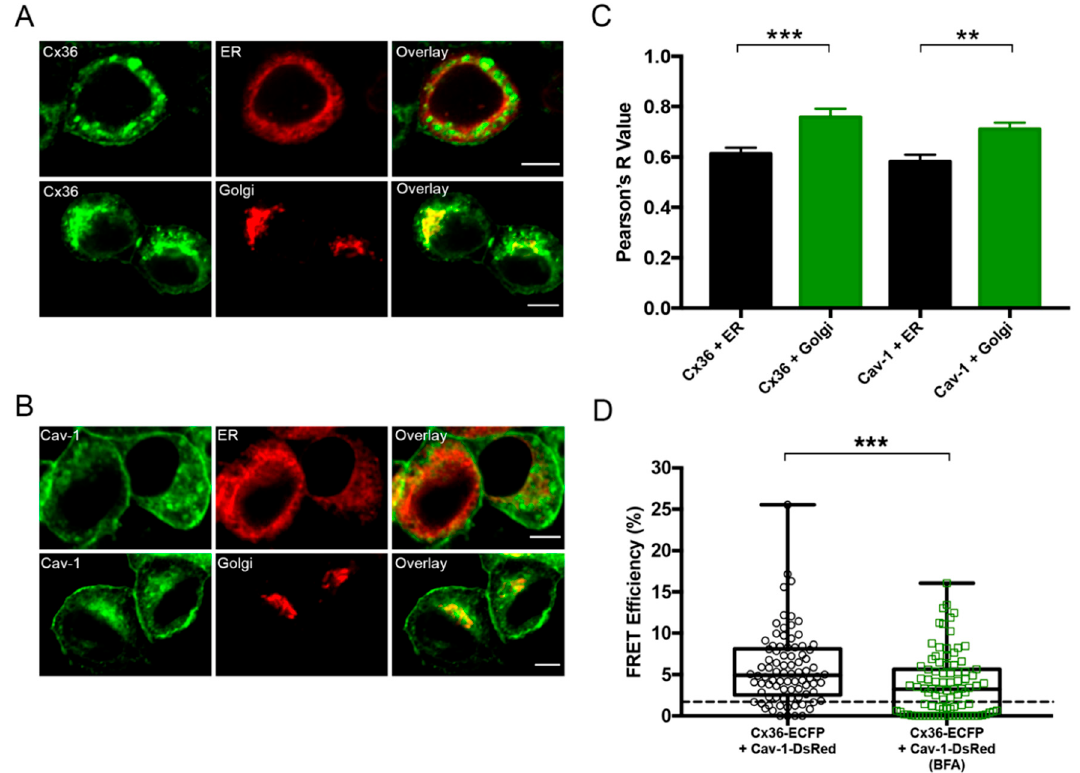
Figure 3. Co-localization with cellular markers and FRET analysis of Cx36 and Cav-1 post Brefeldin A (BFA) treatment. ( A, B ) Co-localization of Cx36-HIS and Cav-1-HA with DsRed-tagged calreticulin (ER marker), and DsRed-tagged galactosyltransferases (Golgi apparatus marker). HIS-tagged Cx36 was detected using an anti-HIS antibody and HA-tagged Cav-1 was detected using an anti-HA antibody. Alexa Fluor 568 was used as a secondary antibody. Scale bar: 5 µm ( C ). Co-localization quantification of the Cx36 and Cav-1 with the organelle markers. Error bars show standard error of the mean. Sample sizes were the following: Cx36 and ER: n = 30; Cx36 and Golgi: n = 20; Cav-1 and ER: n = 21; Cav-1 and Golgi: n = 19. ( D ) FRET efficiencies of Neuro 2a cells transfected with Cx36 and Cav-1 with and without BFA treatment. The threshold of 1.7% (equals to 10nm) is represented by the dotted line. Error bars show the minimum and maximum values. Sample sizes were the following: Cx36-ECFP + Cav-1-DsRed: n = 86; BFA: n = 91. ** p < 0.01, *** p < 0.001.